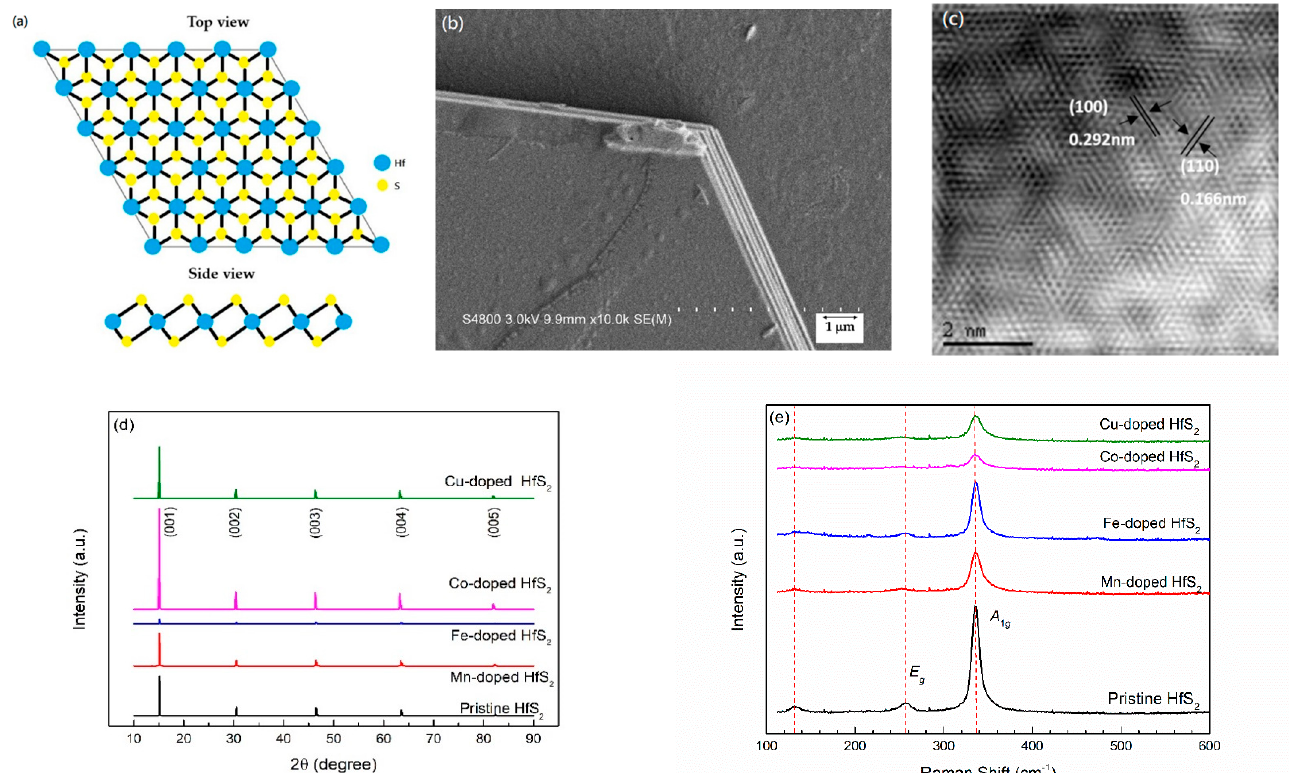
Figure 1. ( a ) Schematic structure of a 1T-HfS 2 crystal; ( b ) Scanning electron microscopy image of the Cu-doped HfS 2 crystal; ( c ) transmission electron microscopy image of the Co-doped HfS 2 crystal; ( d ) X-ray diffraction patterns of the pristine, Mn-, Fe-, Co-, and Cu-doped HfS 2 crystals; ( e ) Raman spectra of the pristine, Mn-, Fe-, Co-, and Cu-doped HfS 2 crystals.